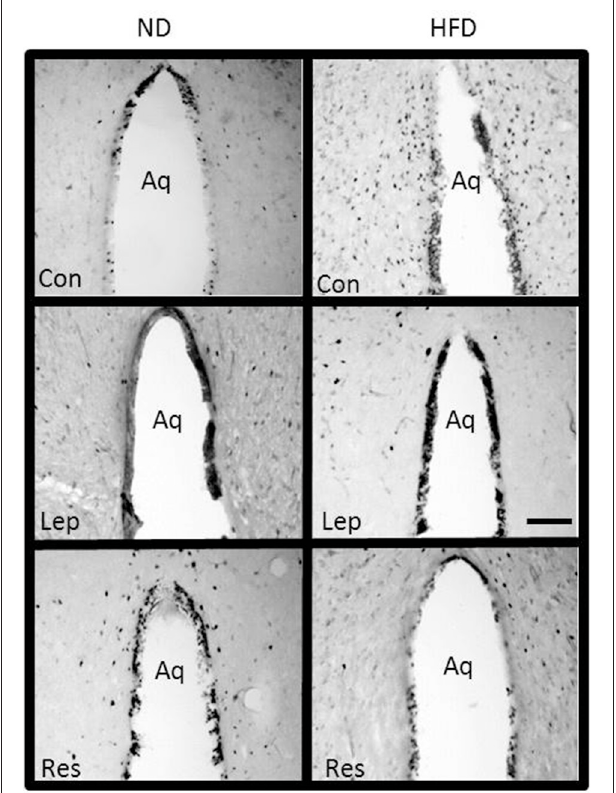
FIGURE 12 | Photomicrographs showing Fos-positive cell nuclei in the periaquaductal gray surrounding the aqueduct (Aq) of rats fed a high fat diet (HFD) and rats fed a normal diet (ND) following centrally administered saline (5 µ l; control), or leptin (7 µ g) or resistin (7 µ g). Scale bar = 100 µ m. The rostrocaudal levels of the sections counted were at ∼ 6.4–7.4mm caudal of